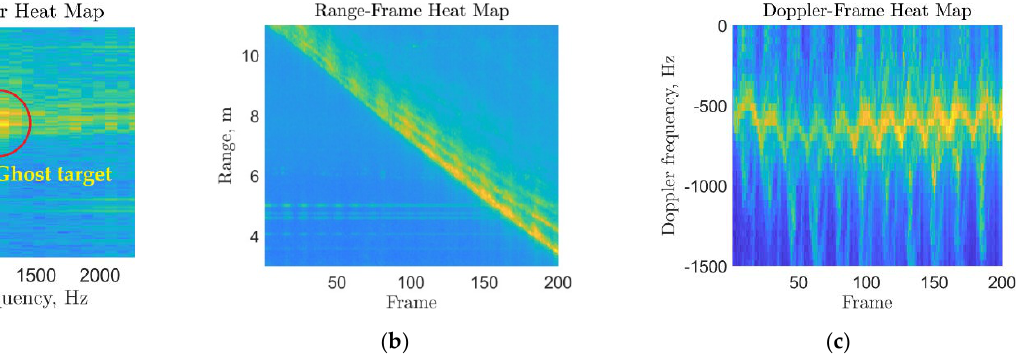
Figure 5. Gait signal processing outputs after the main processing blocks: ( a ) a sample for the range-Doppler map showing the targets’ ranges versus their frequency of motion in a single time frame; ( b ) a sample for the range-frame map showing target movement (range) towards the radar versus time frames; ( c ) a sample for the resulting Doppler-frame map showing the target’s body and limbs’ motion toward the radar.